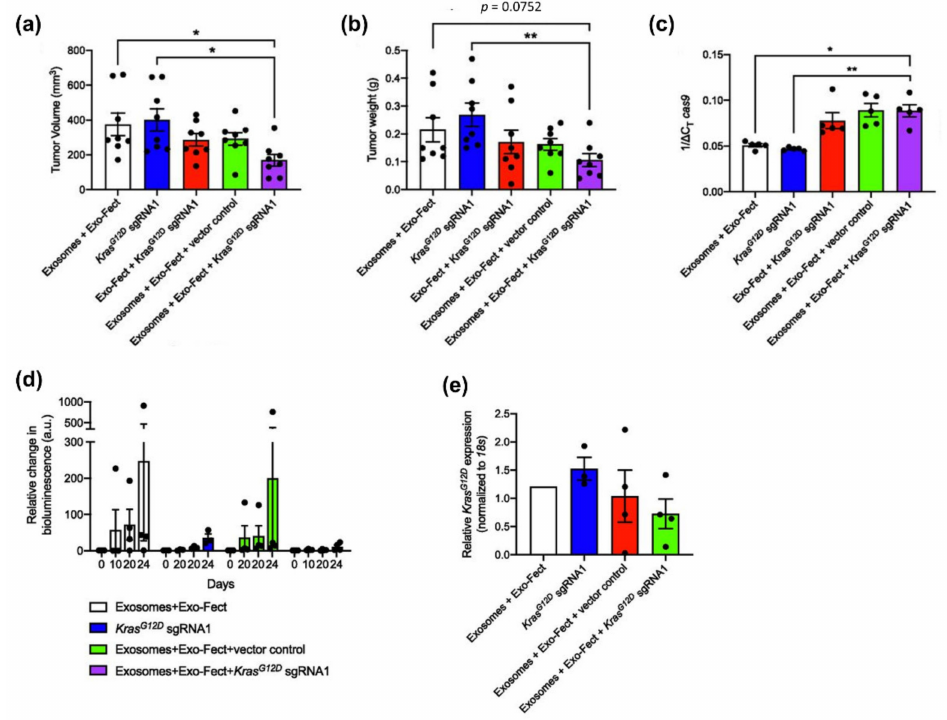
Figure 3. Exosome mediated treatment of CRISPR/Cas9 in as allograft and orthotropic model of pancreatic cancer. ( a , b ) Tumor volume ( a ) and tumor weight ( b ) after exosomes-Cas9/KRASG12D sgRNA intravenously administration in allograft models (KPC689 cells) every other day for 2 weeks ( n = 8 mice in each group). ( c ) Cas9 mRNA expression levels in tumor tissues by quantitative PCR (normalized to 18S, n = 5 mice per group). ( d ) Tumor growth by bioluminescent imaging after exsomes-Cas9/KRASG12D sgRNA Intraperitoneal injection in orthotopic models (KPC689-GFP- Luciferase cells) every other day for 3 weeks. ( e ) KRASG12D mRNA expression levels at the end point in orthotropic tumor tissues (mean ± SD, * p < 0.05, ** p < 0.01) (adapted from Ref.